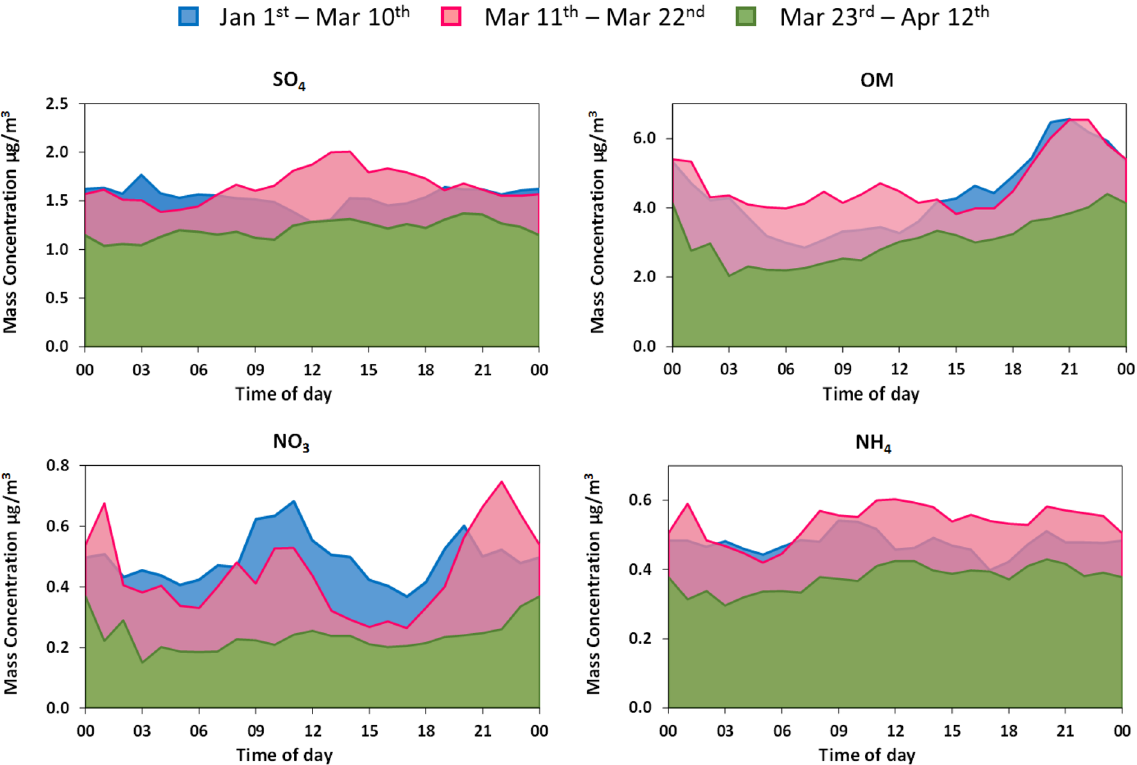
Figure 4. Mean observed variability of hourly concentrations for major Organic (OM) and Inorganic (SO 4 2− , NO 3 − & NH 4 + ) components in the Athens urban background aerosol during the Reference and the 1st and 2nd lockdown